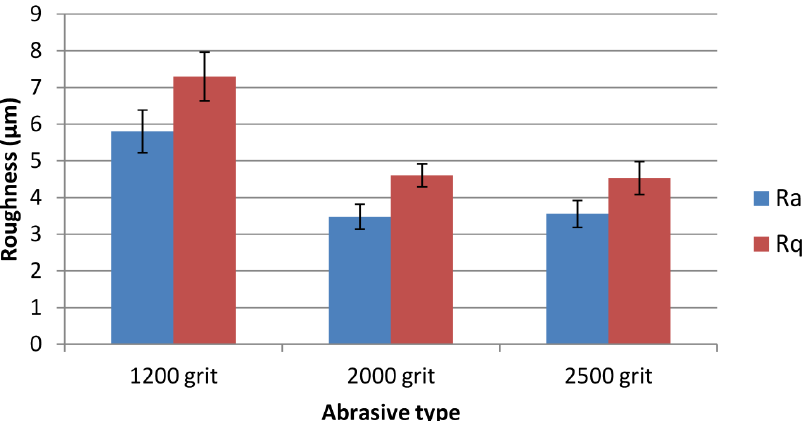
Figure 15. Surface roughness data for abrasives obtained using white light interferometry. Five measurements per abrasive type with error bars showing standard